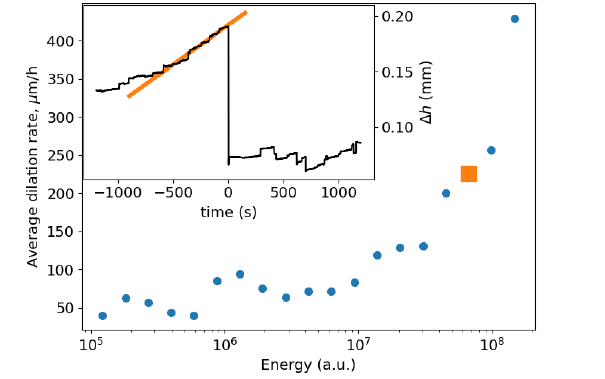
Figure 6. Dilation rate plotted against binned event energy. As events get smaller, the slope continuously decrease to a plateau. The dilation rate is computed by a linear regression on 300s, as shown in the insert, and this particular point is highlighted as an orange square on the main